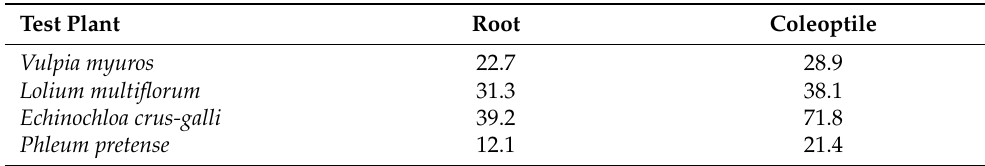
Table 1. IC 50 values of M. glyptostroboides leaf extracts on the growth of roots and coleoptiles of the bioassay plant species. The values (mg fresh weight equivalent extract per mL) were determined with GraphPad Prism.